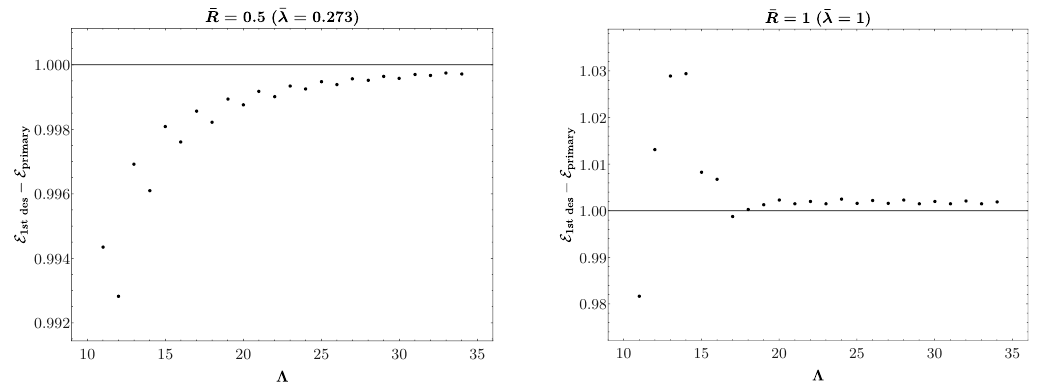
Figure 28. Energy gap between the first primary and its first descendant for two different cou- plings, in the Ising model with a magnetic field.